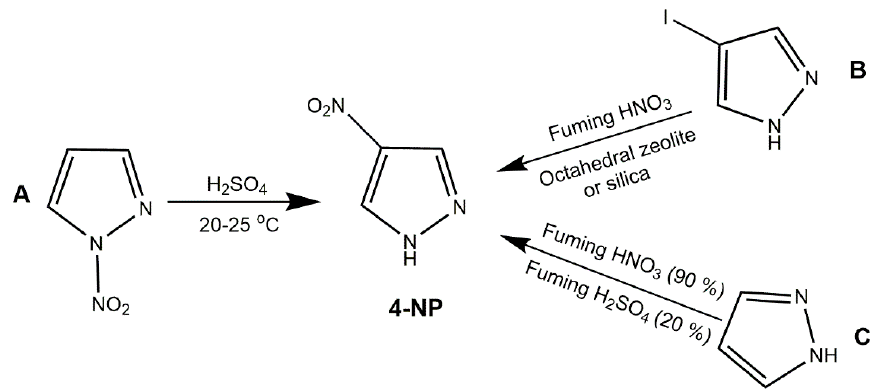
Figure 2. Synthesis of 4-NP.